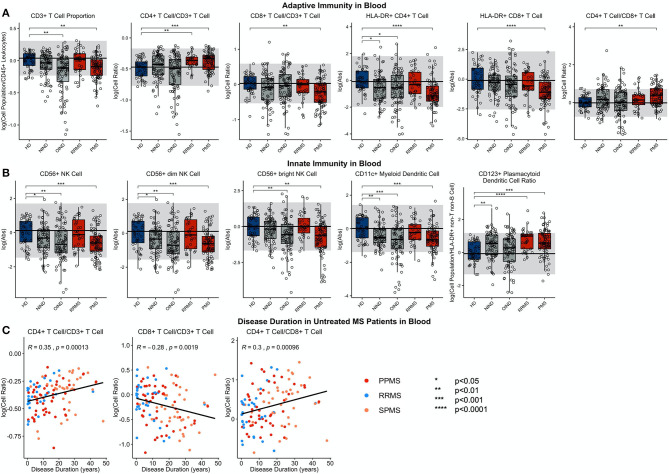
Features that validated in the independent validation cohort in blood during comparison of HDs to RRMS and PMS patients were graphed. HDs, NINDs, OINDs, RRMS, and PMS cohorts for each significant feature were graphed. An unpaired t-test was completed to compare each cohort to HDs with adjustment for multiple comparisons. *p < 0.05, **0.01 < p < 0.005, ***p < 0.001, ****p < 0.0001. The HD median for each feature was also graphed horizontally and gray shading added representing ± 2 SDs of each feature in HD cohort. (A) Features in adaptive immunity. (B) Features in innate immunity. (C) Features that validated were correlated with disease duration and statistically significant features graphed (p ≤ 0.05). MS subtypes were color coded to show heterogeneity of cohorts in each significant feature with blue representing RRMS, red representing PPMS, and orange representing SPMS patients.